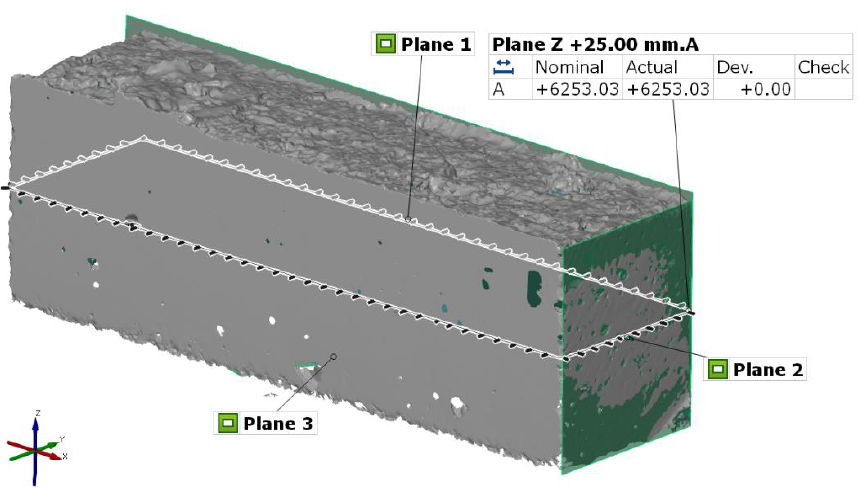
Figure 3. Cross-sectional area of a specimen measured in GOM Inspect (GOM) analytical